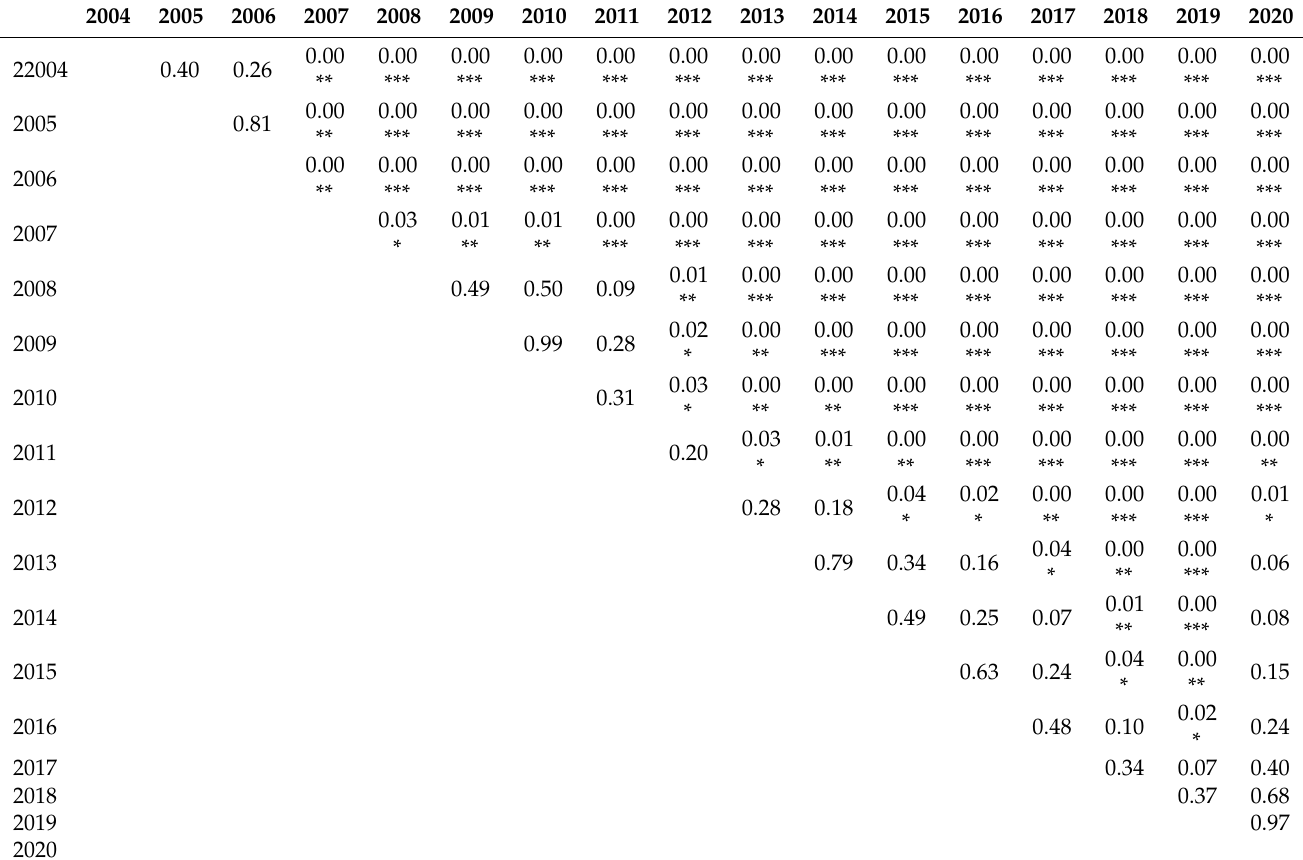
Table 2. t -test for Homoscedasticity in Two Tails for Premium Series, 2004 to